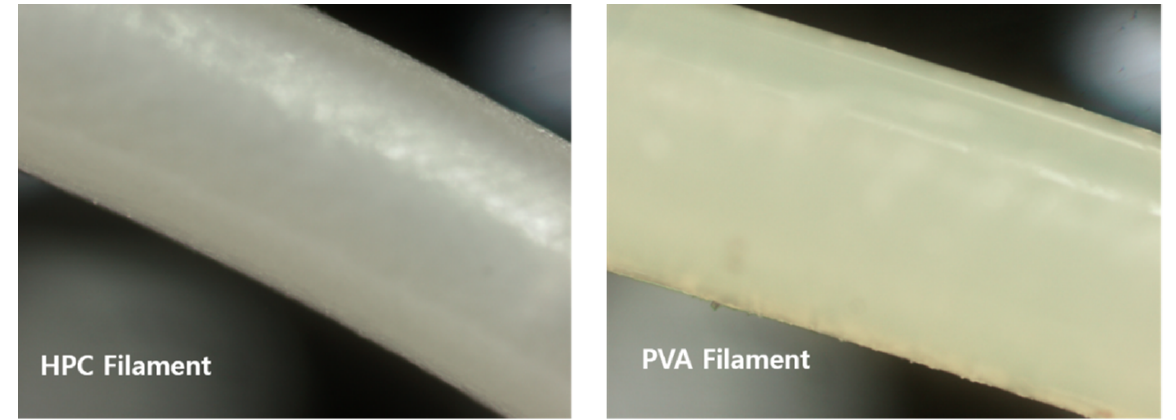
Figure 1. Photographs of the hydroxypropyl cellulose filament and polyvinyl alcohol filament.